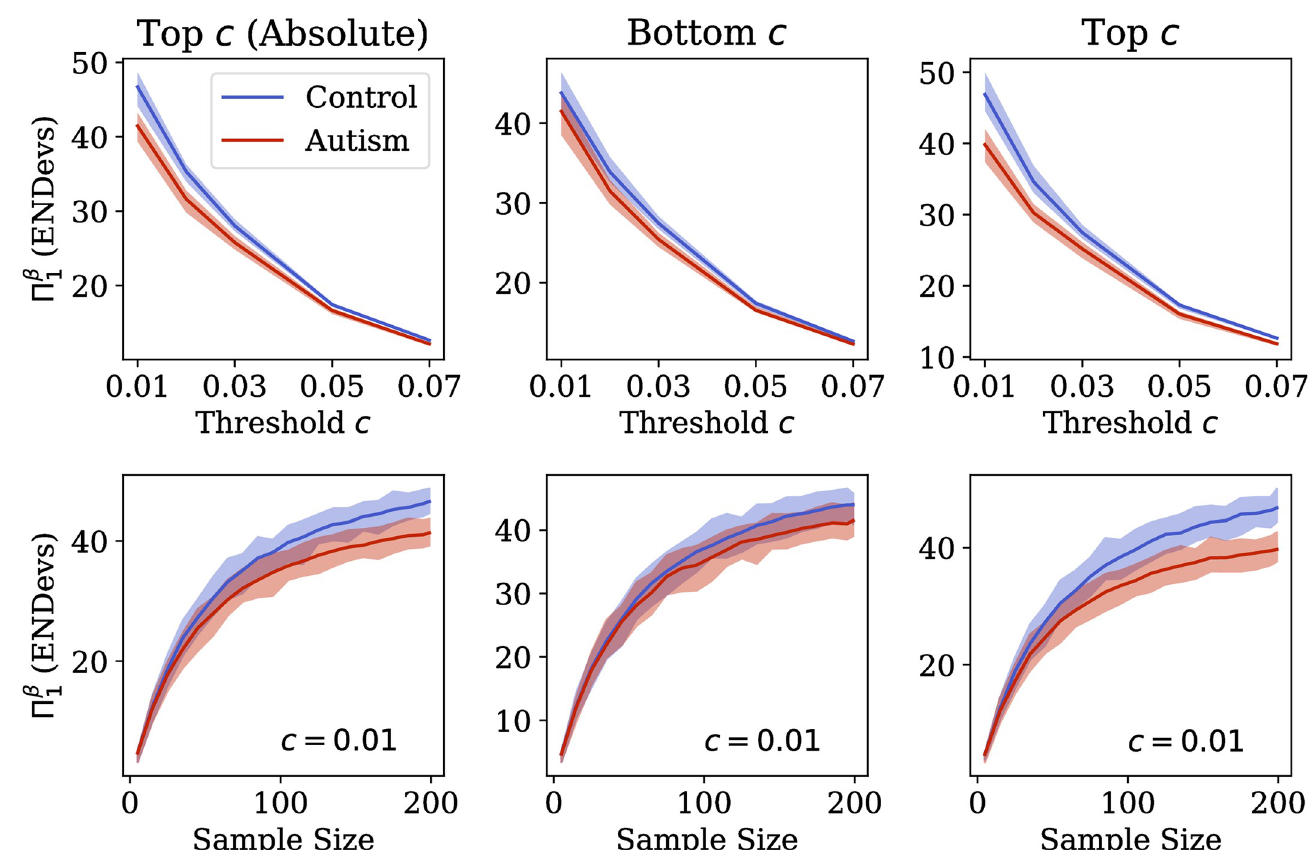
Fig 5. Results of experiment on ABIDE dataset. Top Row : The effective number of deviation patterns (ENDevs; y-axes) across thresholds c for control (blue) and autism (red) subgroups. Bottom Row : Heterogeneity accumulation curves (ENDevs against sample size; at c = 0.01). The leftmost column shows results for the top 100 c % of absolute standardized deviance values, while centre and right columns show results for the lowest and highest 100 c % of standardized deviance values, respectively. Solid lines are means and ribbons are 95% confidence intervals.